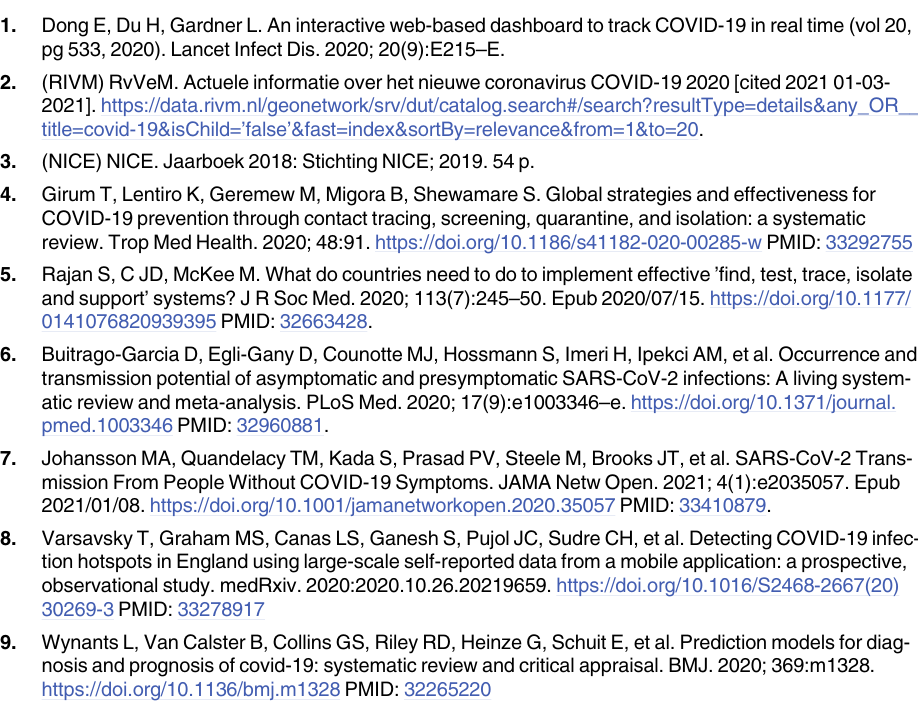
S1 Table. Overview of questions asked in the app. S2 Table. Comparison of excluded and included